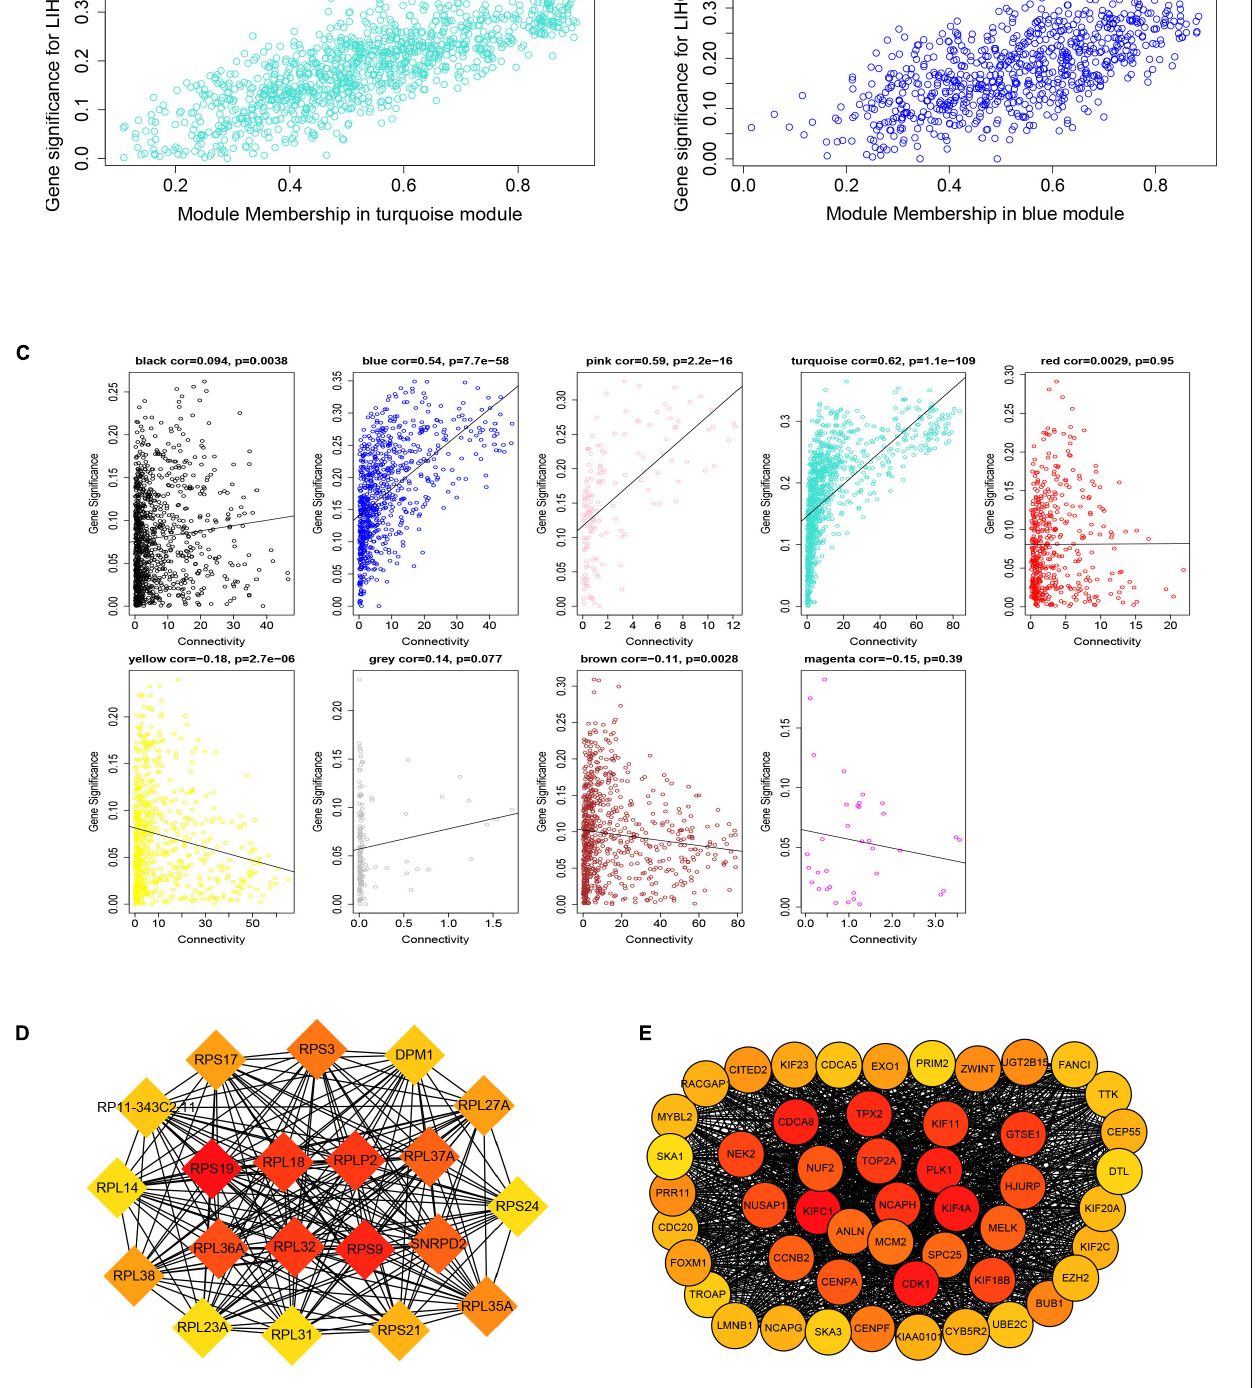
FIGURE 6 | Module membership and corresponding gene significance and protein–protein interaction (PPI) network construction of two key modules. (A) Module membership in the turquoise module. (B) Module membership in the blue module. (C) Relationship between the connectivity of all modules and gene significance. (D) Top 20 hub genes in the blue module according to cytoHubba analysis. (E) Top 50 hub genes in the turquoise module according to cytoHubba analysis.